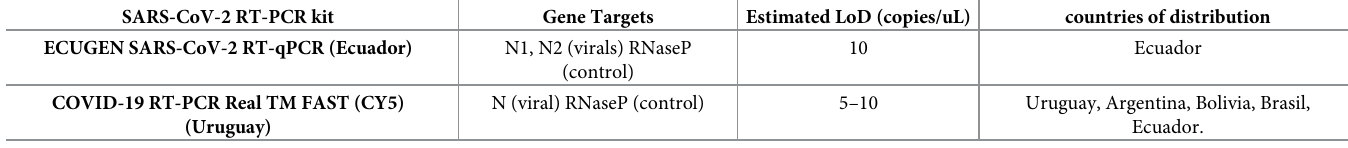
Table 3. Description of ECUGEN SARS-CoV-2 RT-qPCR (UDLA-Starnewcorp, Ecuador) and COVID-19 RT-PCR Real TM FAST (CY5) (ATGen, Uruguay) fea- tures (LoD means limit of detection in copies/uL of RNA extraction elution). SARS-CoV-2 RT-PCR kit Gene Targets Estimated LoD (copies/uL) countries of distribution ECUGEN SARS-CoV-2 RT-qPCR (Ecuador) N1, N2 (virals) RNaseP 10 (control) N (viral) RNaseP